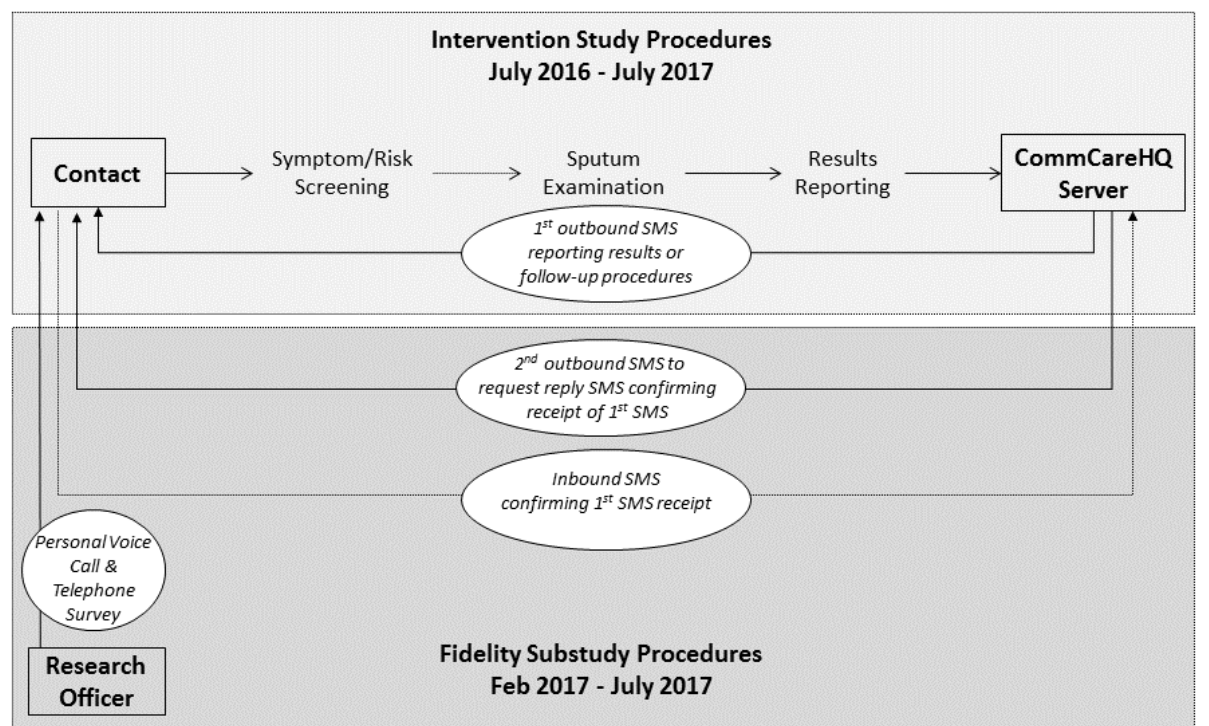
Figure 1. Schema for the short message service (SMS) fidelity